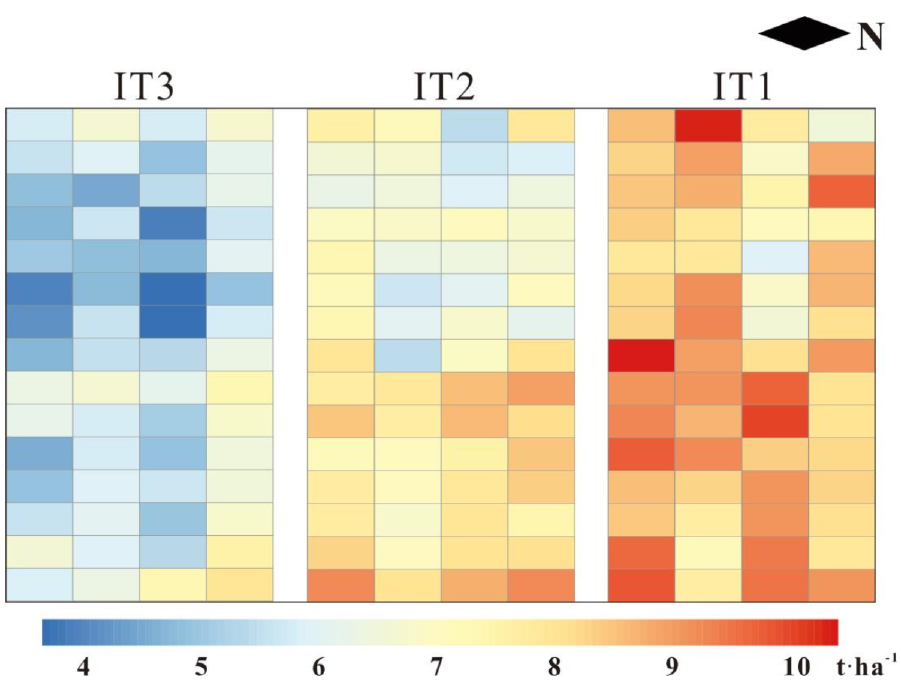
Figure 6. Yield distribution chart for the three irrigation treatments. The color scale from blue to red indicates the increasing grain yield from 4 to 10 t ha − 1